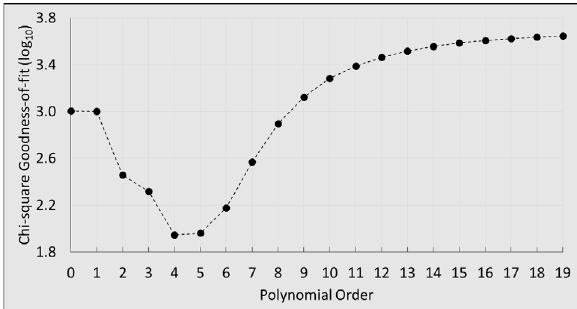
Figure 12. Chi-square goodness-of-fit regarding polynomial order to convert discrete cumulative movements (SBAS) into continuous form for target point 6 (Figure 3).